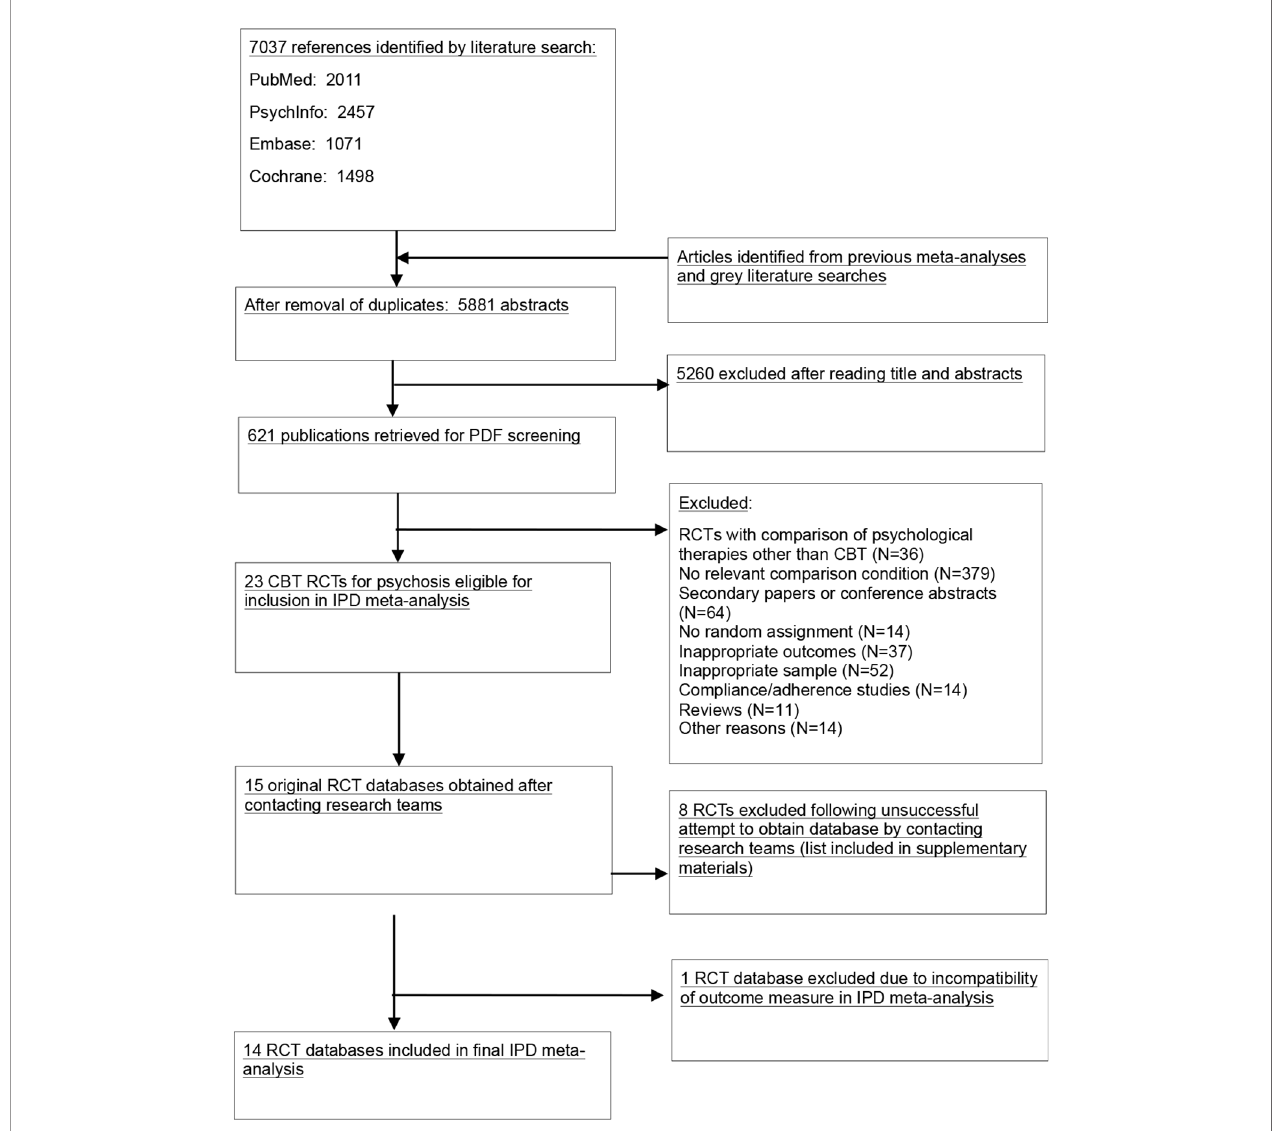
FIGURE 1 | Flowchart of inclusion of